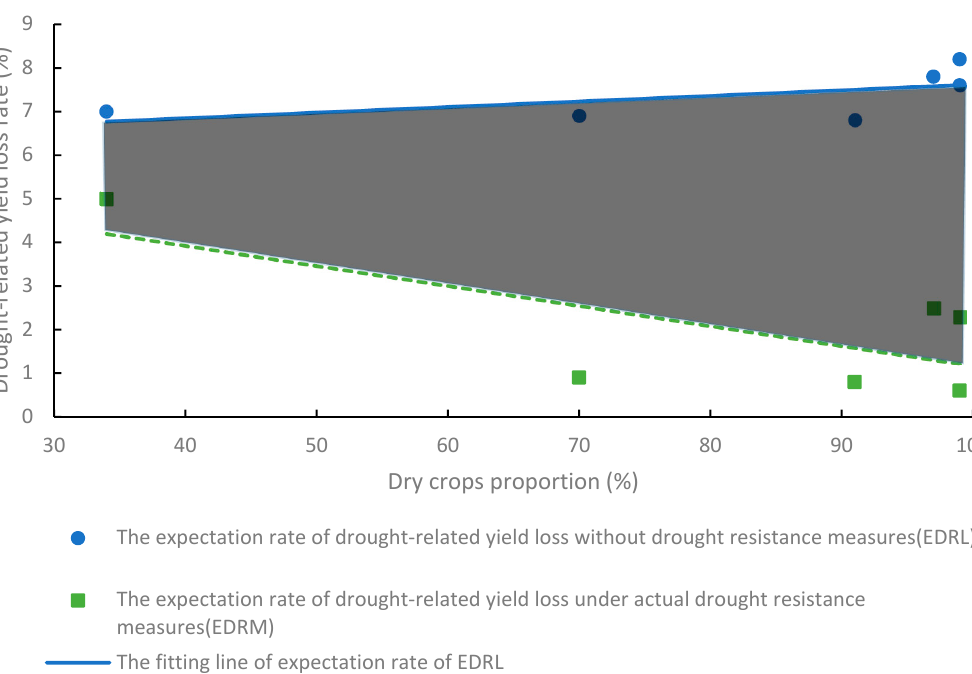
Figure 6. Variation in the drought-related yield loss rate without drought mitigation measures (EDRL), drought-related yield loss rate with actual drought mitigation measures (EDRM), and the expectation of drought mitigation effects (EDRE) with variation in the dry crop proportion in the study site.